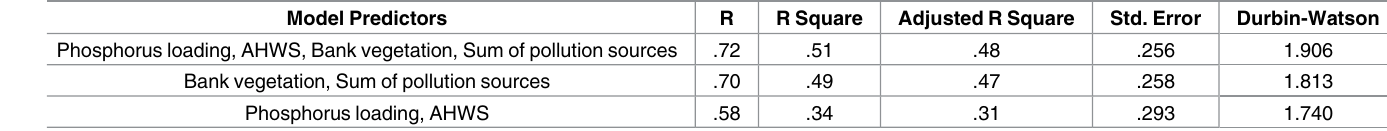
Table 2. Multiple linear regression analysis for sub-basin phosphate concentrations using microscale and macroscale